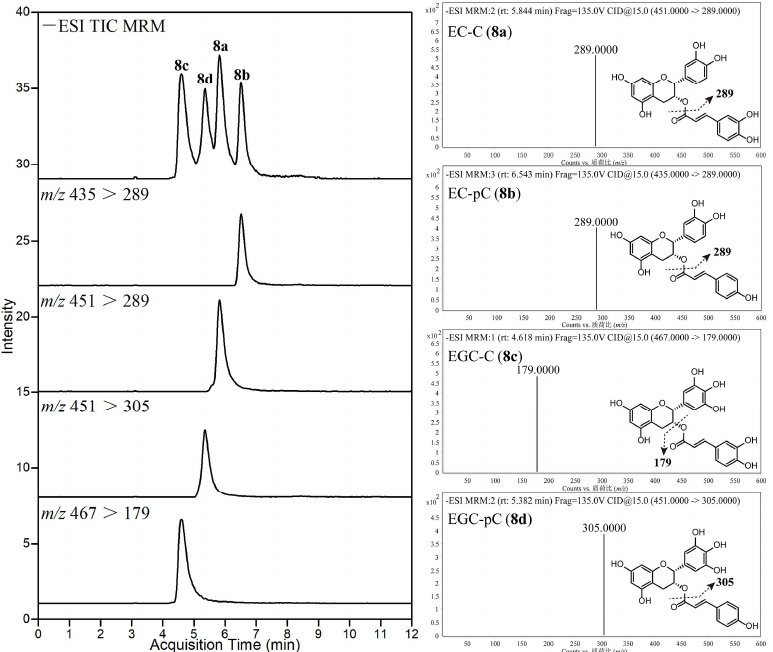
Figure 6. UHPLC-QqQ-MS/MS analysis of the four hydroxycinnamoylated catechins (HCCs) standards. Reprinted with permission from ref. [16] . Copyright 2021 Elsevier.